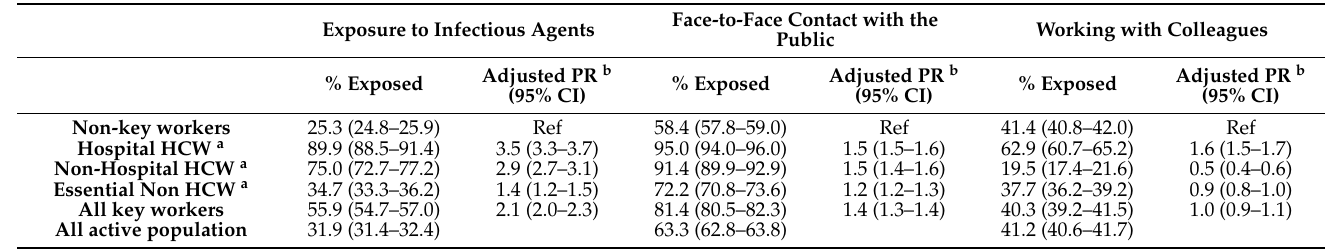
Table 3. Estimated adjusted prevalence ratio (PR) of exposure to the three work-related exposure factors in each sub-group of key workers, compared to non-key workers (stratified models). Exposure to Infectious Agents Face-to-Face Contact with the Public Working with